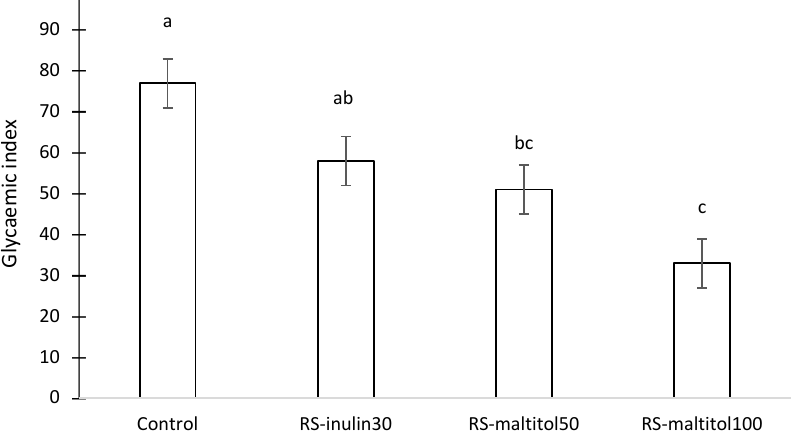
Figure 4. Glycaemic index of gluten-free biscuits made with unconventional flours, resistant starch and sucrose replacers. Control: biscuits made with buckwheat, sorghum and lentil flours (50:30:20) and 19% sucrose (based on total dough weight); RS-inulin 30, formulated as the Control but with part of the flours replaced by resistant starch (11.50% of total dough weight) and 30% replacement of sucrose with inulin; RS-maltitol 50: formulated as the Control but with part of the flours replaced by resistant starch (12.00% of total dough weight) and 50% of sucrose replaced by maltitol; RS-malt- itol 100 as the Control but with but with part of the flours replaced by resistant starch (11.50% of total dough weight) and total replacement of sucrose with maltitol. Data are reported as mean value ± SEM. Different letters indicate different means according to Tuckey HSD test ( p < 0.05). Regarding inulin and maltitol, they are both considered low GI ingredients [45,46]. Maltitol is included in the list of food additives and no maximum level has been specified for its use. However, foods containing more than 10% of added maltitol, or polyols in general, must bear a warning of possible laxative effects [47,48]. Similarly, no maximum limit has been recommended for inulin use. However, incorporating a high amount of inulin into biscuit formulation made the dough processing very challenging [30]. Inulin is not hydrolyzed in the human digestive tract due to the lack of inulinase; being a non- digestible carbohydrate it can contribute to lowering the blood glucose level [49]. Maltitol is a polyol partially absorbed by the small intestine. Matsuo [50] evaluated glucose re- sponses after the ingestion of 50 g maltitol or of a maltitol:sucrose mixture (50:50). The GI of maltitol was significantly lower than that of sucrose, which was in agreement with other reported data [51]. Other researchers investigated the glycaemic response to glucose and maltitol in three ethnic groups and found that the absorption of these sugars was not affected by ethnicity [52]. To the best of our knowledge, there are no other research papers that have evaluated the effect of sucrose replacement on the GI of gluten-free biscuits by in vivo study with human subjects. Recently, Atkinson et al. [53], who reviewed and tabulated published and un- published sources of reliable GI values, suggested that 84% of 135 biscuit references were within low the GI classification, whereas only 12% and 4% were of medium GI and high GI, respectively. Of the reported data, only two samples were indicated as gluten-free biscuits and both were low GI products. These samples were commercial gluten-free “Frollini” (GI = 37) [54] and chocolate-coated gluten-free cookies (GI = 35) (Sydney Uni- versity‘s Glycemic Index Research Service (Sydney, Australia), unpublished observa- tions). This information seems to contradict the view that gluten-free products have a high GI. For example, Packer et al. [38] reported a high GI for digestive gluten-free biscuits (GI = 83). Gluten-free products generally present a higher GI when compared to their gluten